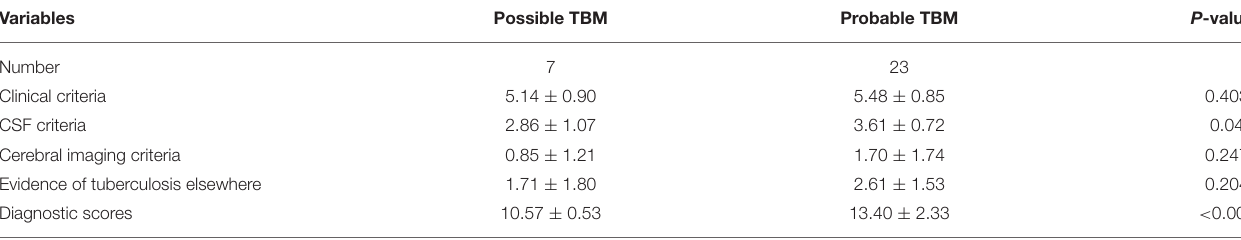
TABLE 3 | Diagnostic scores of four sets of TBM diagnositc criteria between probable and possible